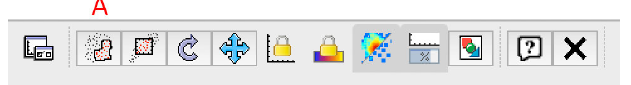
you can always click on the “Axes” symbol in the lower left part of the window, choose the “Range” tab, and ad- just the range either by entering minimum and maximum values directly or by changing the sliders. Do so to get a closer look on the offset concentration, as in Fig.